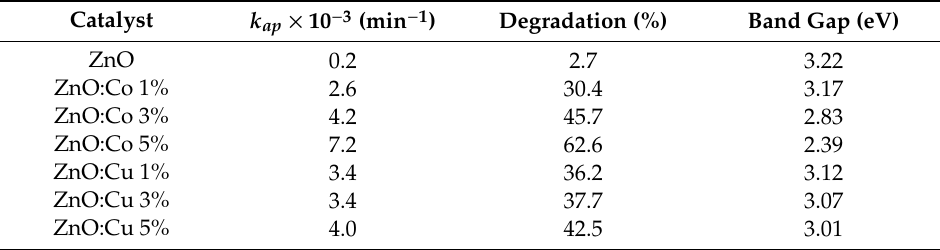
Figure 6. Methylene blue (MB) concentration vs. time of visible irradiation on the synthesized catalysts.